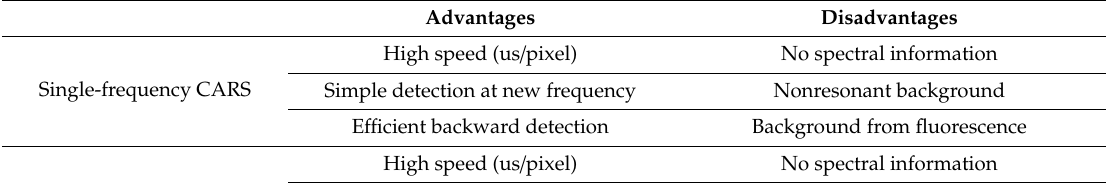
Table 1. Advantages and disadvantages of di ff erent Raman-based imaging techniques. Reproduced from [26], with permission from Taylor and Francis Group LLC (Books) US,